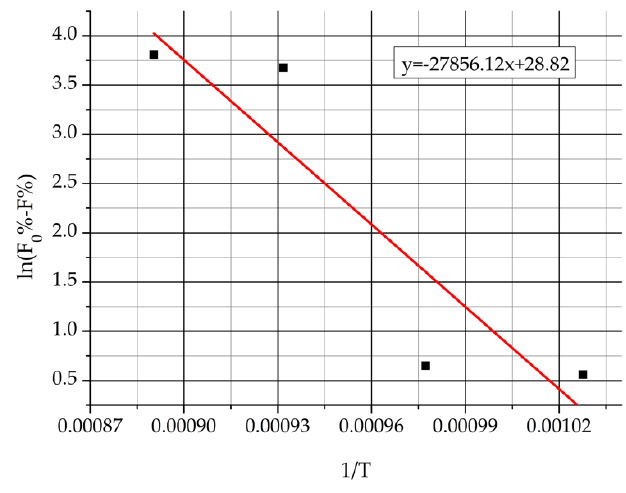
Figure 18. Arrhenius plot of the ε = 61.9% deformed original sample series. Figure 19 represents the obtained activation energy values of the second sample set in function of the rolling reduction.